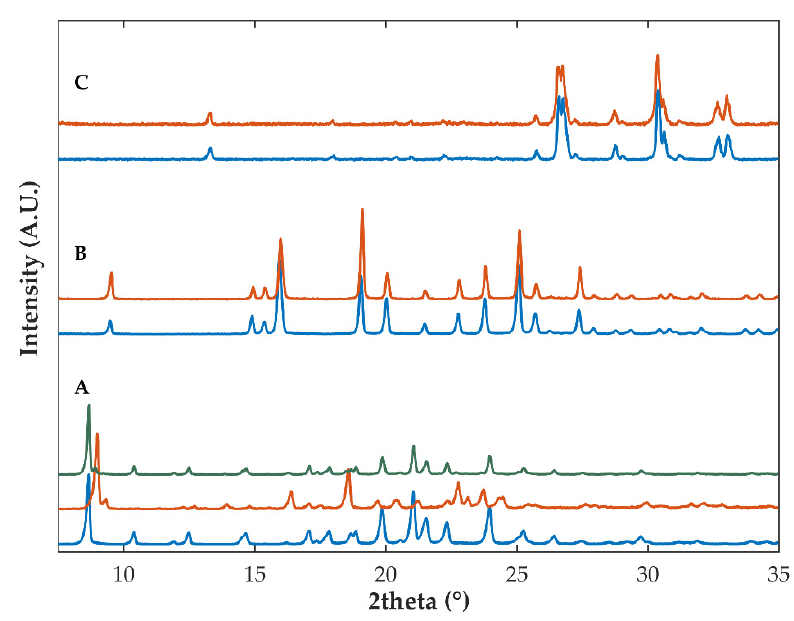
Figure 5. Diffractograms of control samples containing either olanzapine ( A ), saccharin ( B ) or the placebo-based formulation ( C ) before (in blue) and after (in orange) exposure to 25% of water. The diffractogram of olanzapine in green represents the sample containing wetted olanzapine after drying under room conditions (23 °C/65% RH).